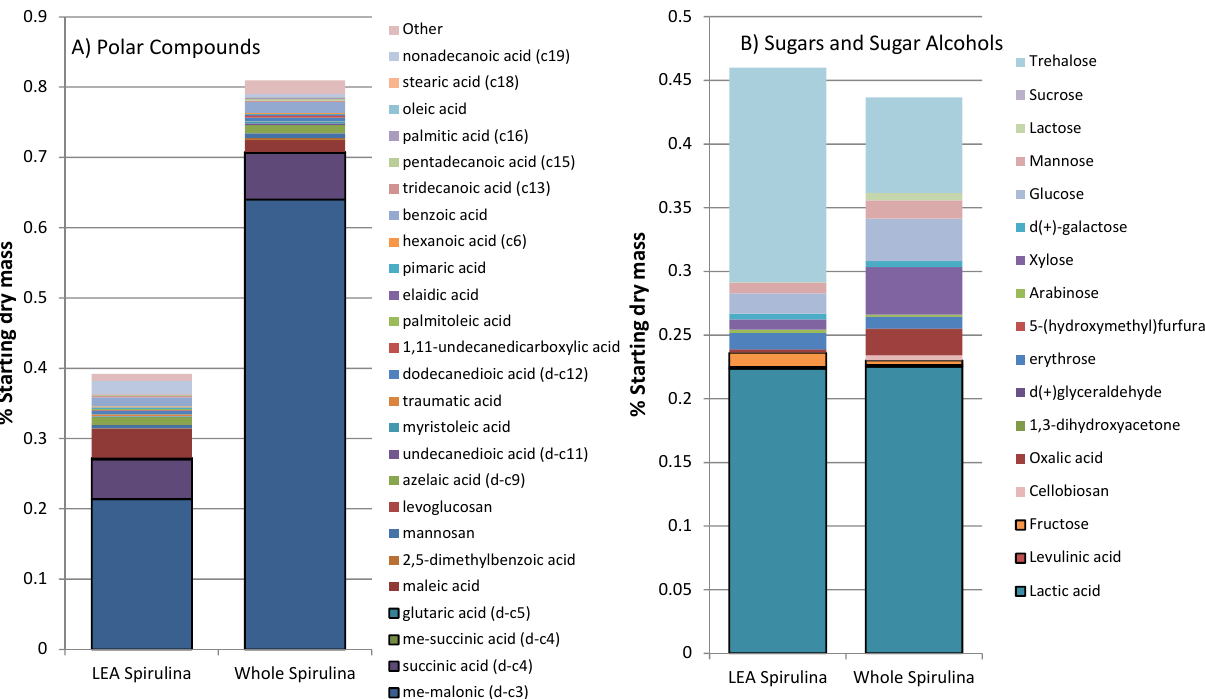
Figure 5. GC/MS analysis of ( A ) polar compounds; and ( B ) sugars and sugar alcohols in aqueous products resulting from HTC treatment of whole and LEA Spirulina at 175 °C. Species that are identified as high value chemicals are indicated by